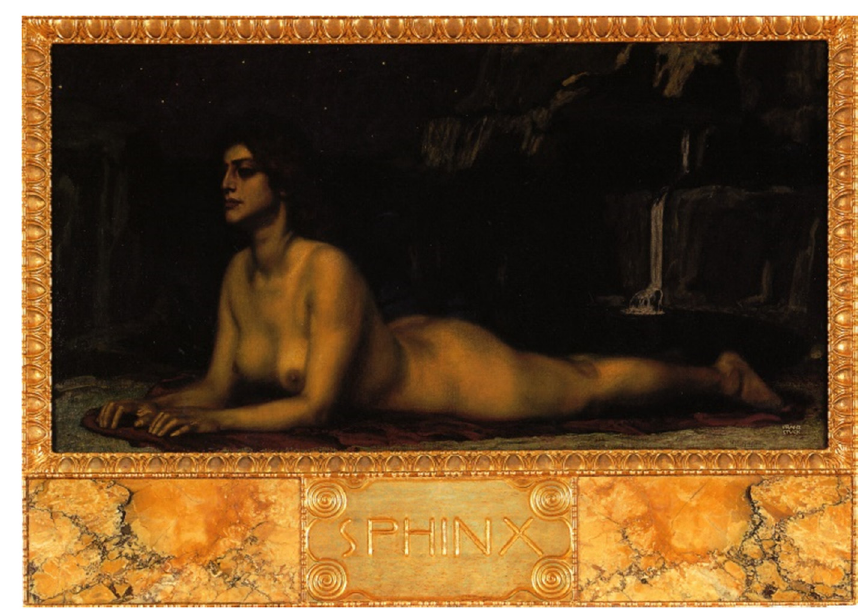
Figure 36: Franz von Stuck, Sphinx , 1904. Darmstadt, Hessisches Landesmuseum. Public